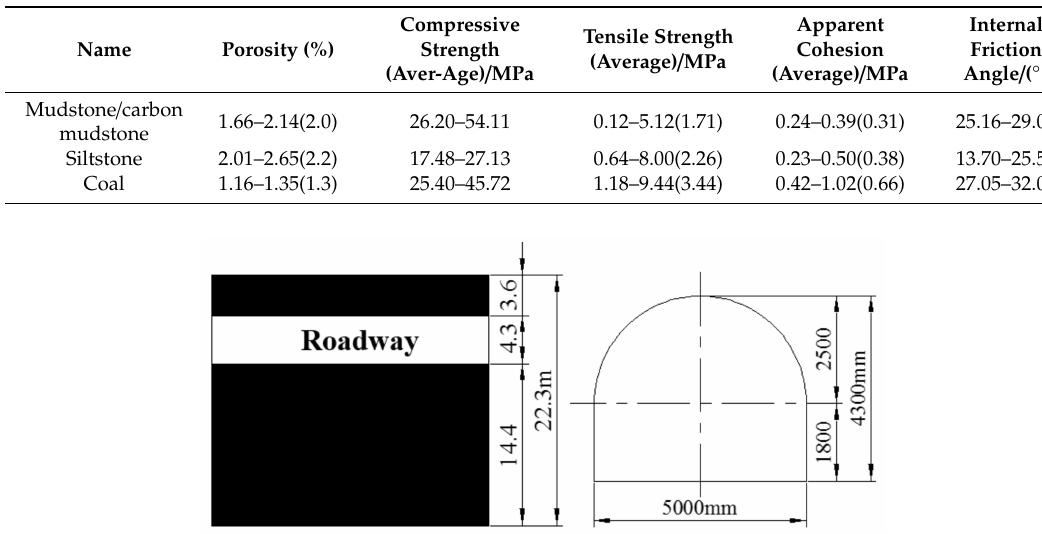
Table 1. Basic mechanical parameters of the roof and floor rock formation in the 2# coal seam.